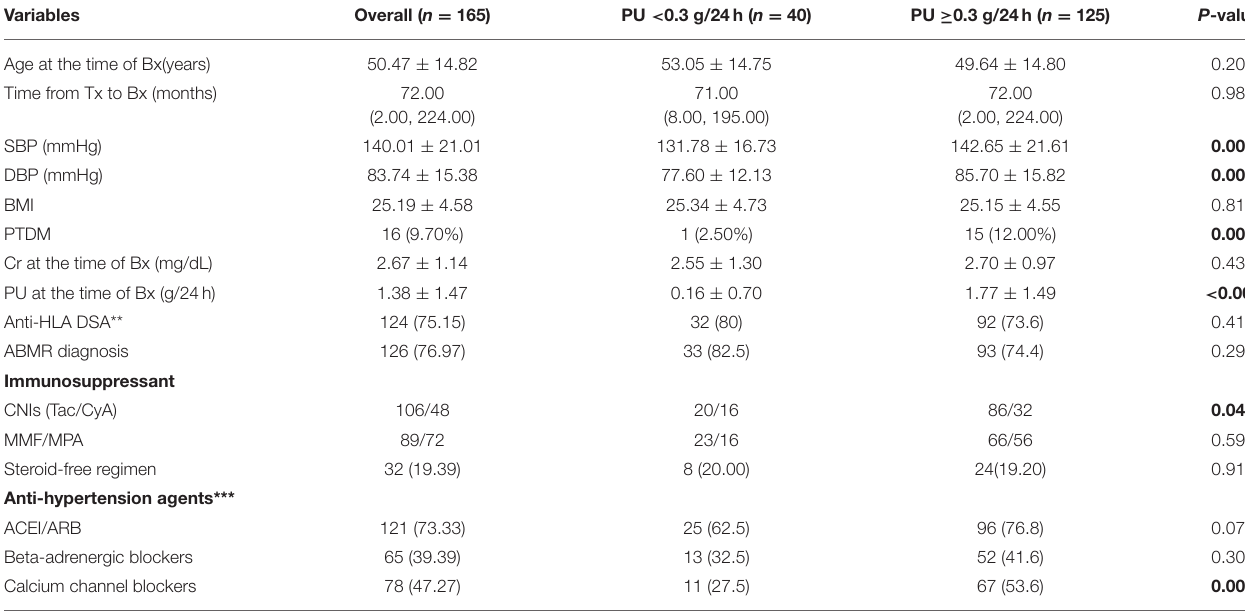
TABLE 2 | Patients’ demographics and clinical characteristics at the time of biopsy for TG. Variables